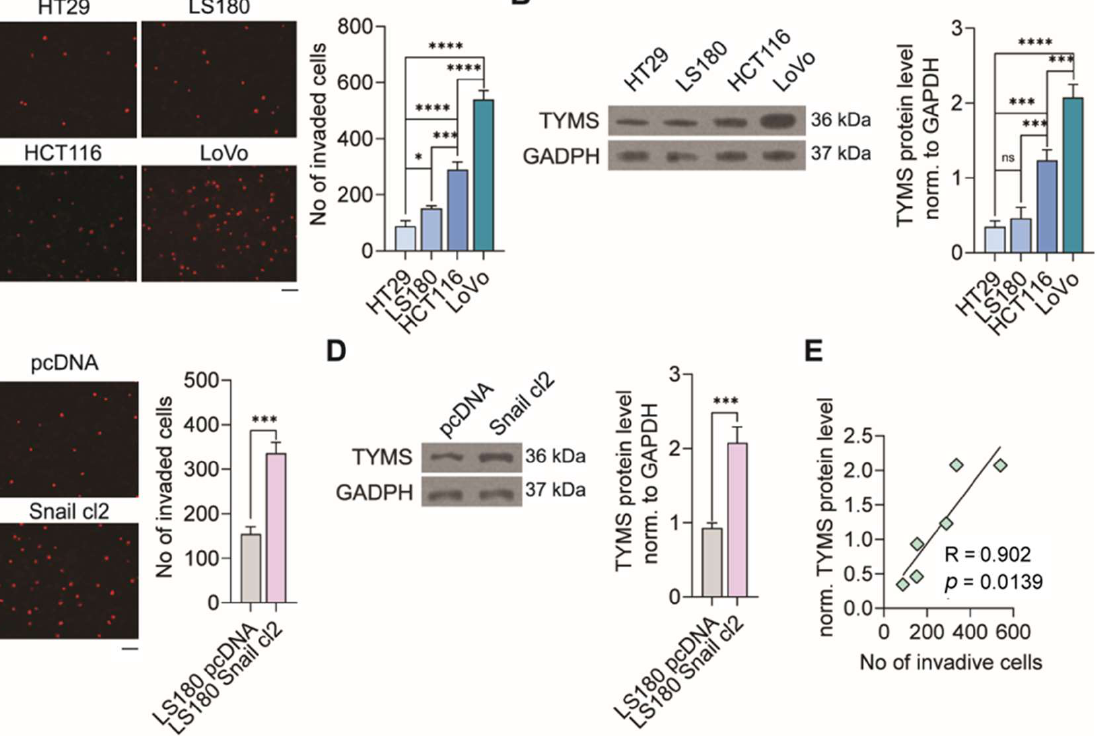
Figure 1. Correlation between TYMS protein level and invasion potential of colon cancer cells. Colon cancer cells ( A ) with different invasiveness properties and ( C ) Snail overexpressing cells were characterized according to their ability to transmigrate through matrigel. The representative images are shown. Scale bar 100 µ m. The graphs are displaying means ± S.D. ( n = 3); * p < 0.05, *** p < 0.001, **** p < 0.0001. Western Blot-measured TYMS protein level in ( B ) CRC panel and ( D ) Snail overexpressing cells. Representative blots are shown, and graphs displaying the mean protein level normalized to GAPDH ± SD ( n = 3). ns—non-significant; *** p < 0.001, **** p < 0.0001. ( E ) Linear regression between TYMS protein level and colon cancer cells invasion